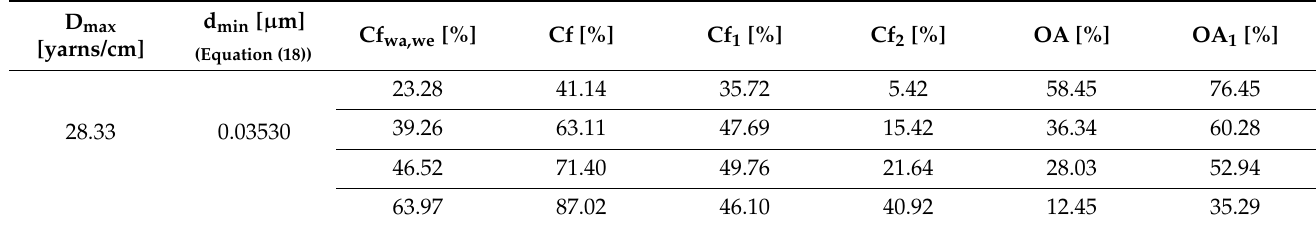
Table 6. Calculated values ( c ) of UV parameters double- (T 2 , R 2 , A 2 ) layered CO samples and the absolute values of their differences compared with measurement ( me ) values and the conformation of their connections with the coefficient of cor- relation. Table 9. D max , d min , calculated values of Cf, Cf wa , Cf we , Cf 1 , Cf 2 , and OA for PET samples.